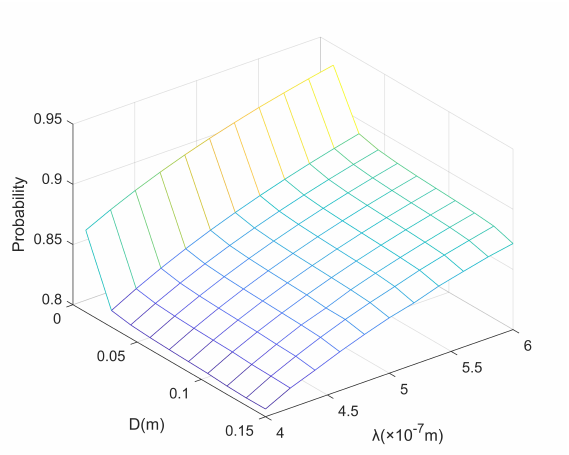
Figure 5. Received probability of the OAM signal modes of DARR beam versus wavelength λ and received diameter